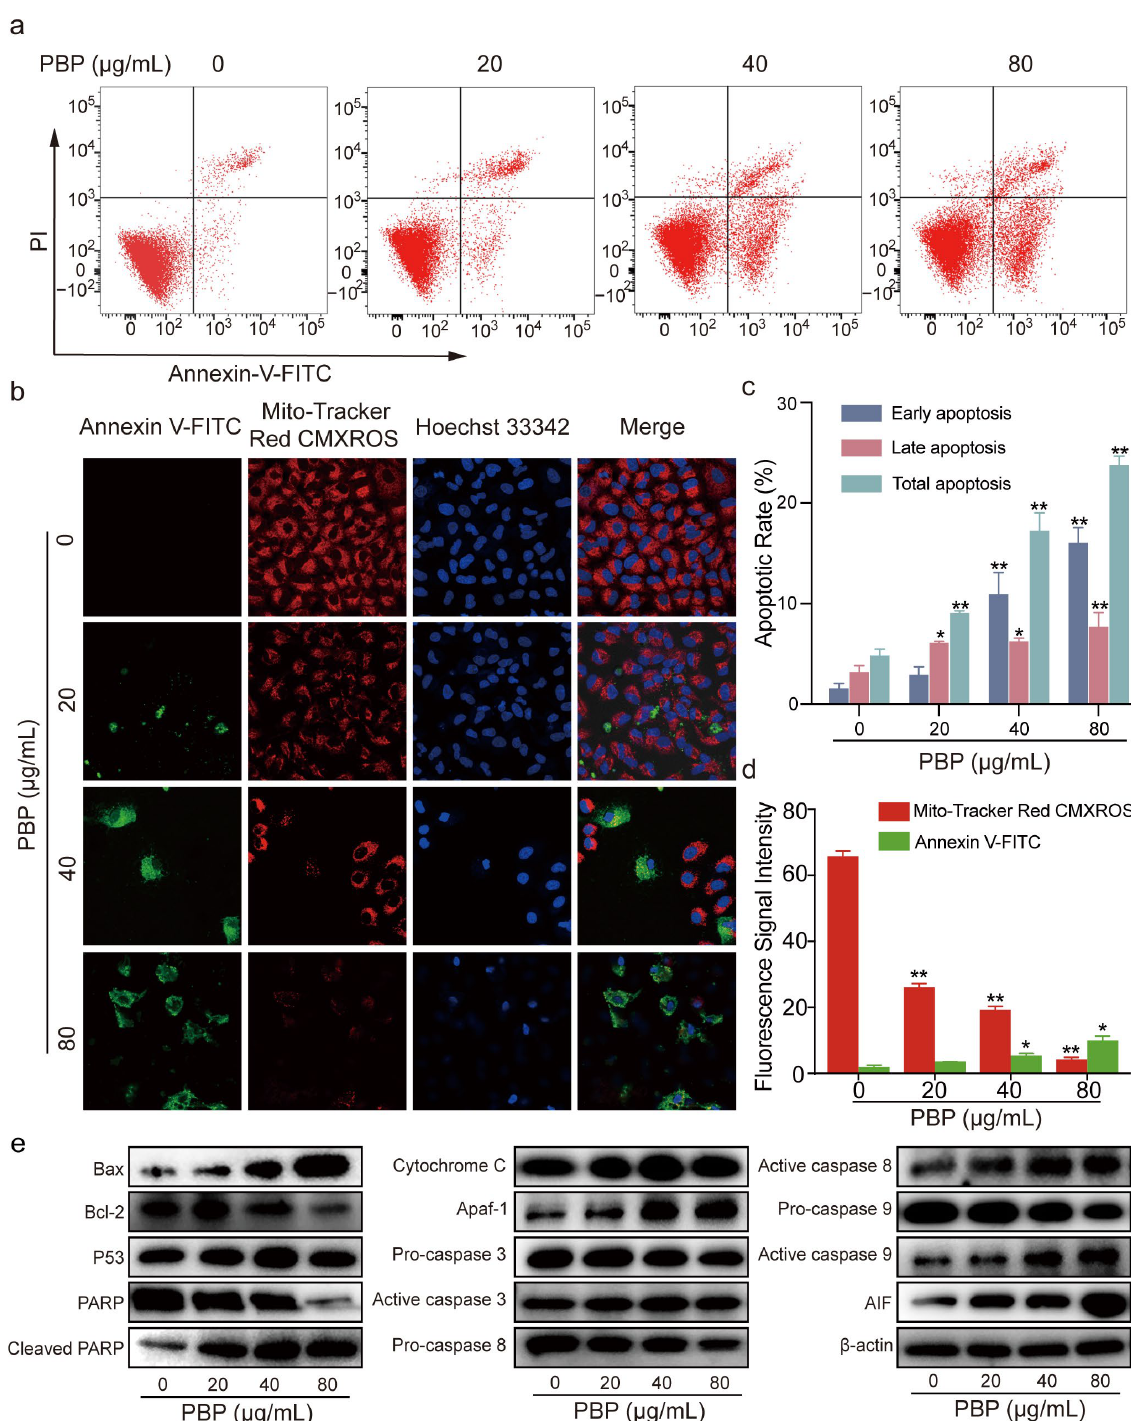
Figure 6. PBP induced apoptosis and caused MMP depolarization in A549 cells. ( a ) A549 cells were incubated with PBP (0, 20, 40 and 80 μg/mL) for 48 h and then stained with Annexin V-FITC and PI for evaluation by flow cytometry; ( b ) The MitoTracker Red CMXRos fluorescent probe was used to detect the MMP in A549 cells using a mitochondrial membrane potential detection kit and laser confocal microscopy; ( c ) Histograms of the apoptotic rates of A549 cells treated with PBP; ( d ) Histograms were used to determine the average fluorescence intensity; ( e ) Expression of apoptosis-related proteins was analyzed by western blot analysis. Data are presented as the mean ± SD ( n = 3) by One-way ANOVA analyses. ** p < 0.01, * p < 0.05 versus control (0 µ g/mL